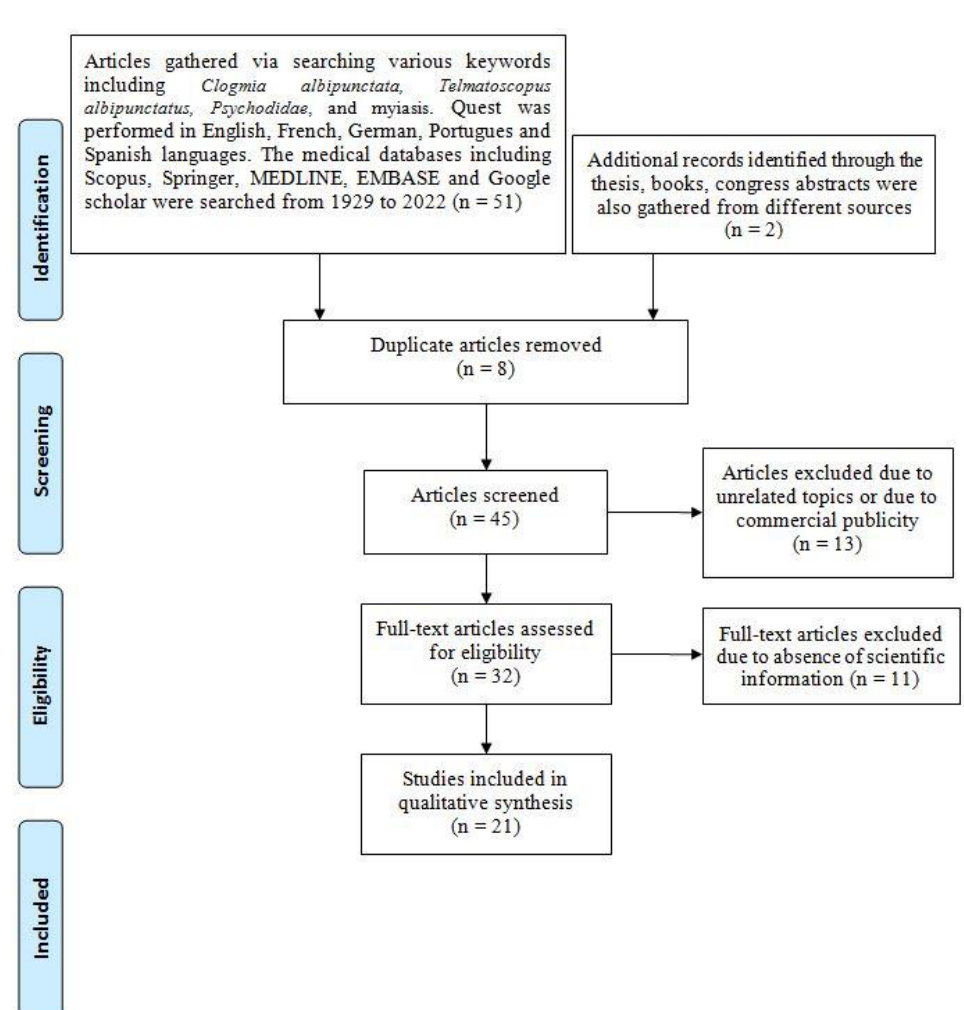
Figure 3. Literature quest strategy used in the present study.